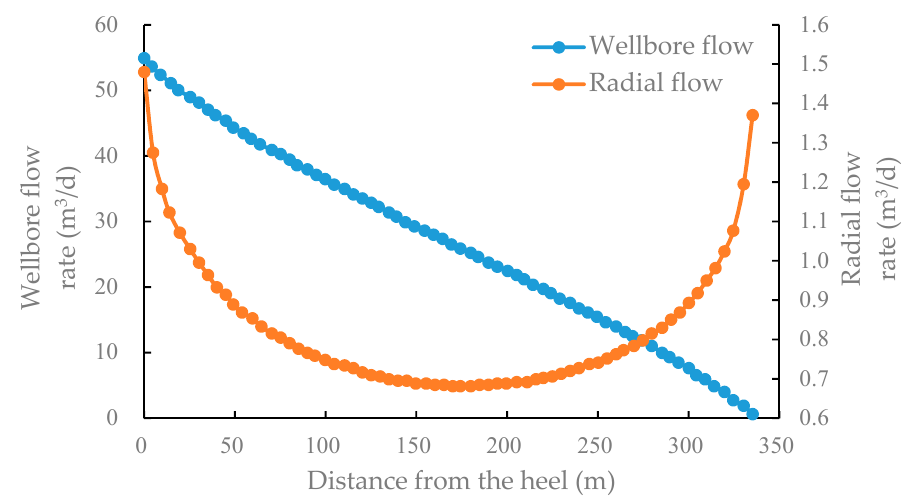
Figure 9. Distribution of wellbore flow and radial flow along the horizontal lateral.